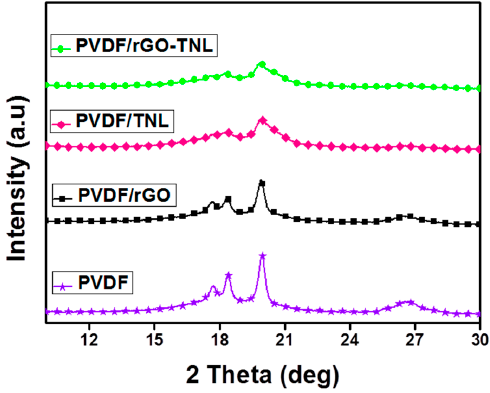
Figure 9. X-ray diffraction pattern of PVDF, PVDF/rGO, PVDF/TNL, and